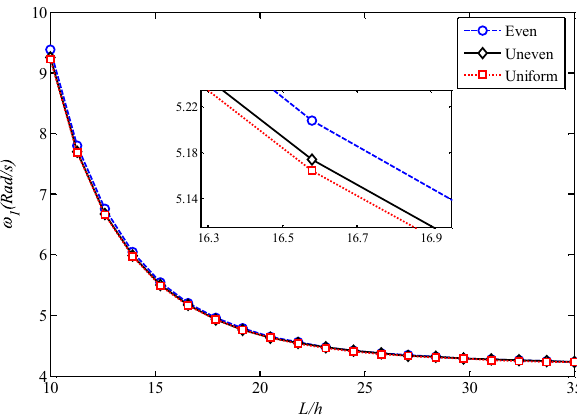
Figure 2: E ff ect of porosity coe ffi cient and R / h ratio on the funda - mental natural frequency ( h = 0.01 m , h c = 10 h f , L = 20 h , φ r = 2 π , μ = 1 ) U